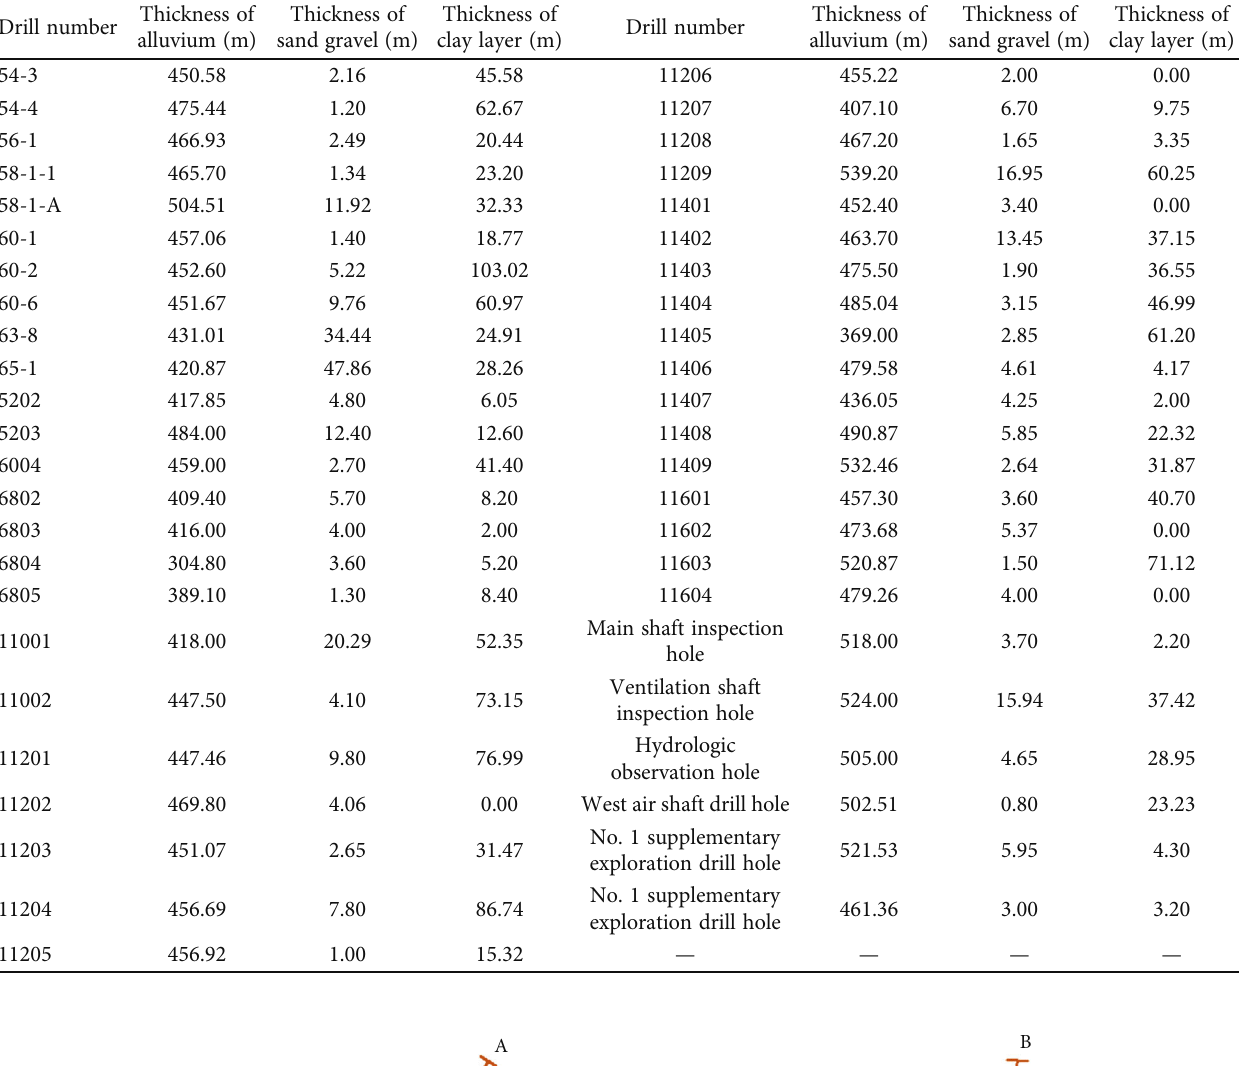
Table 1: Structural characteristics of north fl ank alluvium.